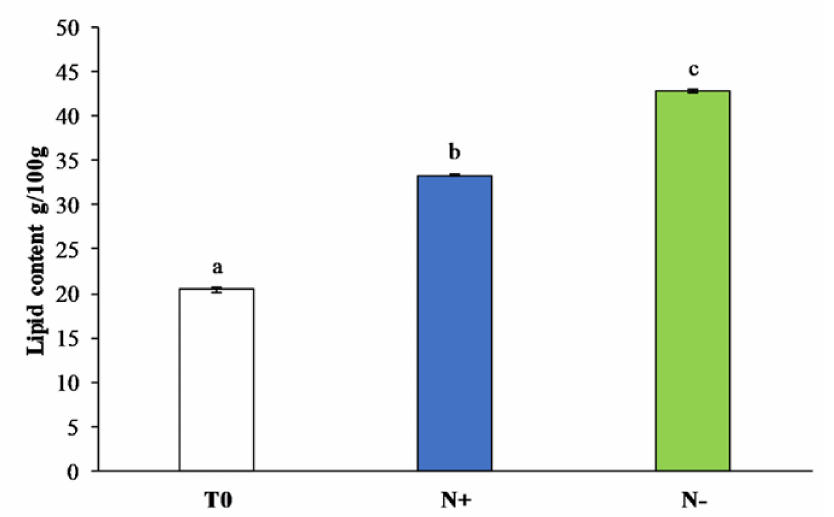
Figure 3. Total lipids (g/100 g) of P. tricornutum cultivated for 15 days under initial culture conditions (T0, white bar), under standard conditions (N+, blue bar), and under starvation conditions (N − , green bar). Values are expressed as the mean ± SEM ( n = 3) with standard deviations. Different letters indicate statistical differences ( p < 0.05) between groups.